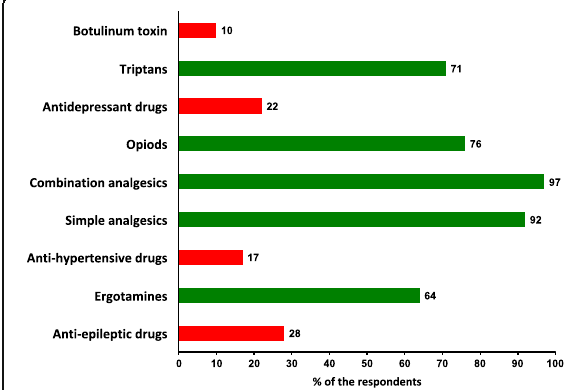
Fig. 1 Percentage of the participants who stated that each of the given medication can lead to medication-overuse headache. Green bars represent those medications that are known to cause medication-overuse headache, while red bars represent those that do